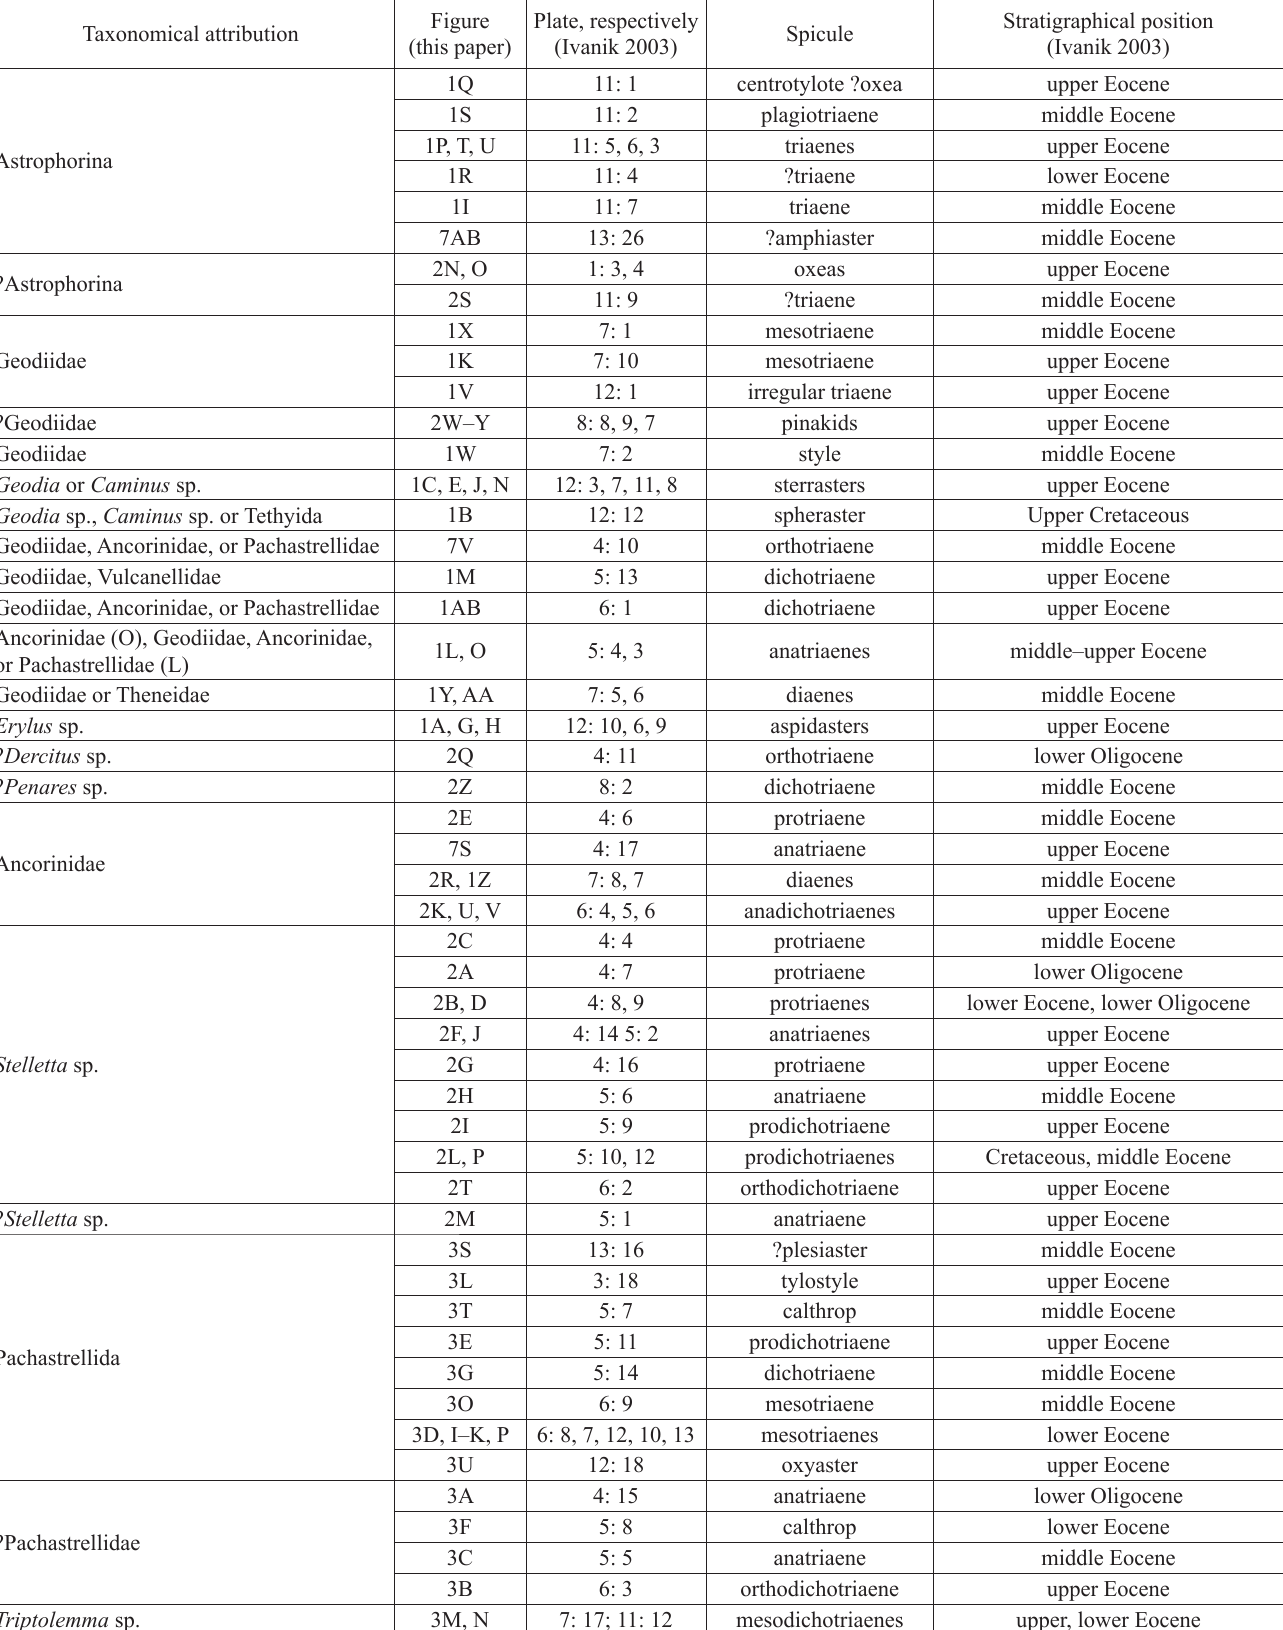
Table 1. Taxonomic affinity of spicules from the East-European Platform and adjacent regions illustrated by Ivanik (2003). Taxonomical attribution